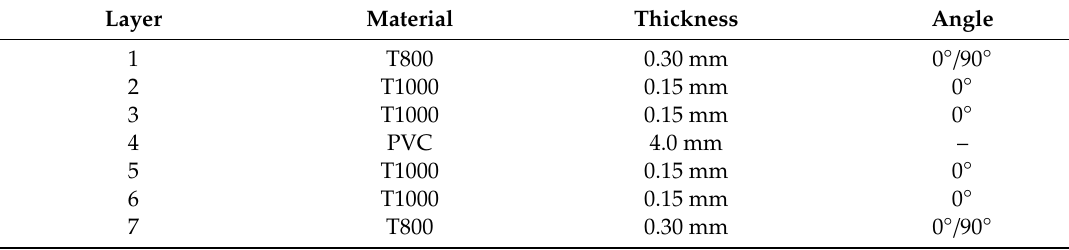
Table 2. Composite layout.